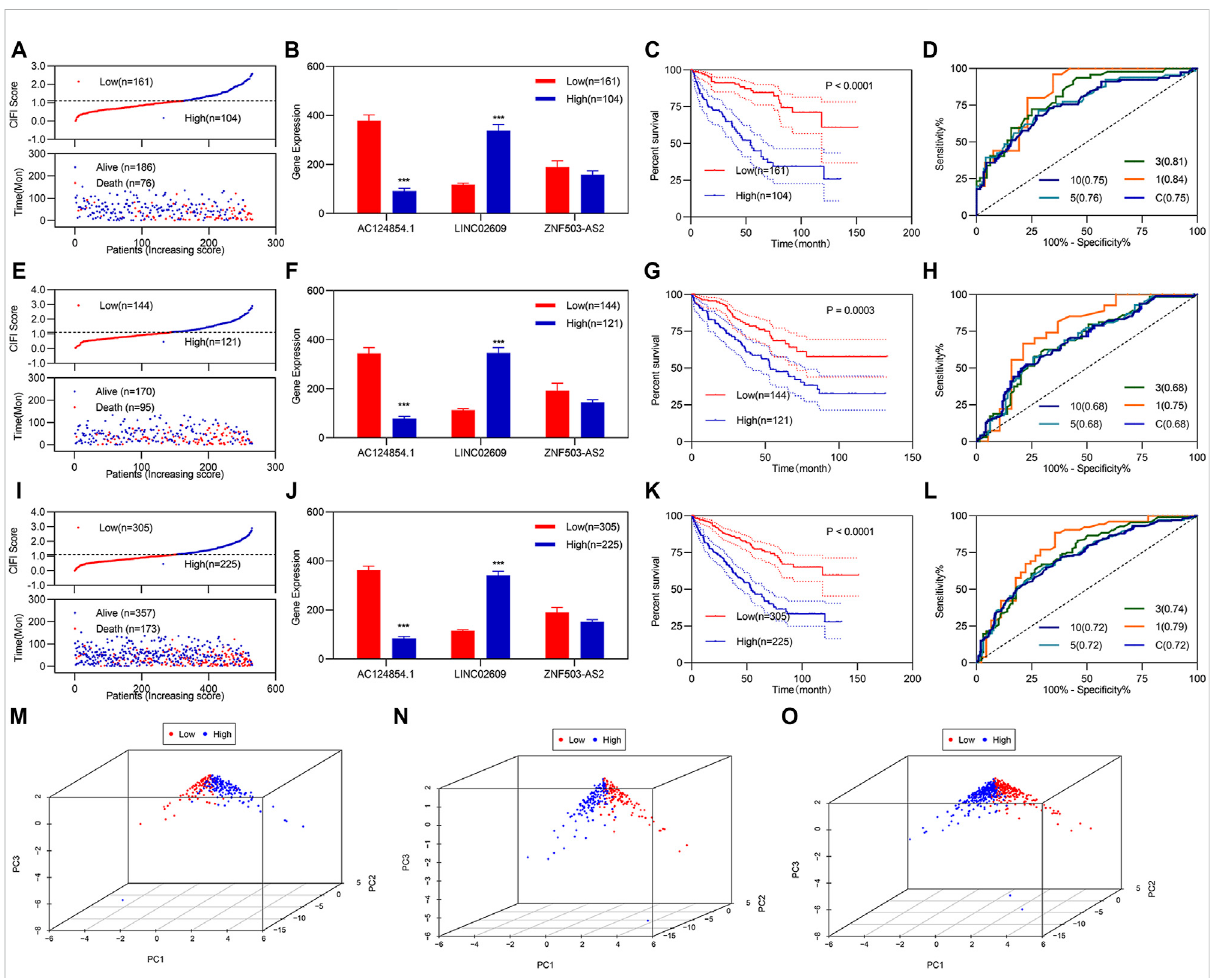
FIGURE 2 DevelopmentandvalidationofCIFIasaprognosticmodel. (A – D) and (M) Analysisoftheprognosticmodelinthetraininggroup( n =265). (A) For risk value (up) and survival status (down) for each patient. (B) Expression of the three candidate biomarkers. (C) K-M curve of KIRC patients with different CIFI values. (D) ROC curve of the risk assessment model. (M) Distribution of patients with different CIFI values. (E – H) and (N) Analysis of the prognostic model in the validation group ( n = 265). (E) For risk value (up) and survival status (down) for each patient. (F) Expression of the three candidate biomarkers. (G) K – M curve of KIRC patients with different CIFI values. (H) ROC curve of the risk assessment model. (N) Distribution of patients with different CIFI values. i-l and o Analysis of the prognostic model in the entire group ( n = 530). (I) For risk value (up) and survival status (down) for each patient. (J) Expression of thethree candidate biomarkers. (K) K – M curveof KIRC patients with differentCIFI values. (L) ROC curveof risk assessment model. (O) Distribution of patients with different CIFI values. * p < 0.05, ** p < 0.01, *** p <